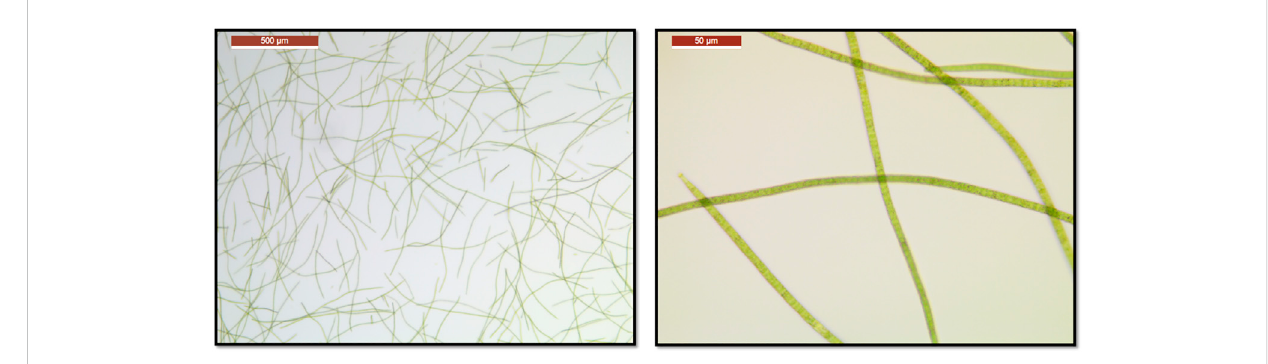
FIGURE 1 Light Microscopy pictures of Limnospira indica PCC8005 P3 at two different magni fi cations (left: ×50, right: 400X) showing long (in average ~700 μ m; up to 1.5 mm) and straight